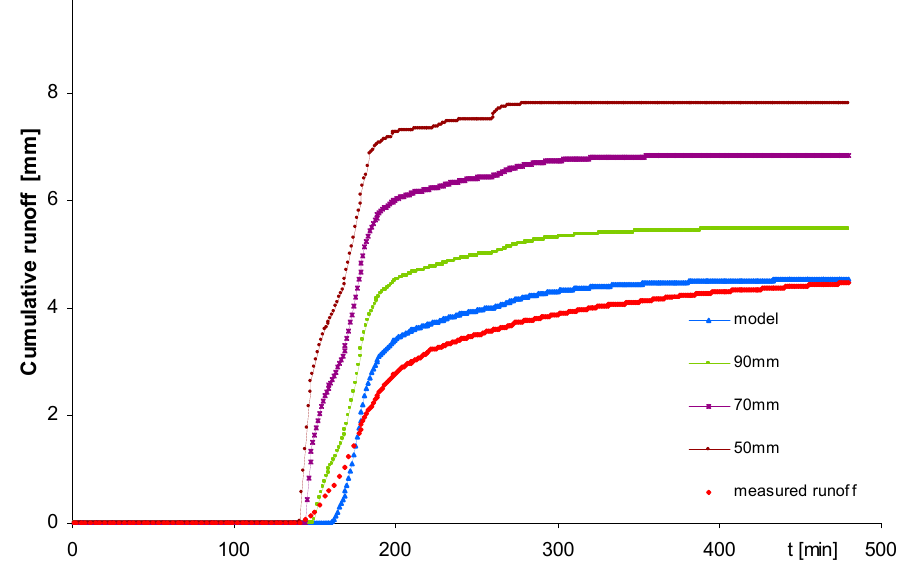
Figure 5. Comparison of measured and simulated cumulative runoff. The effect of increasing the outflow depending on the depth of the pumice-based vegetation layer (GR2) on 28 July 2017.